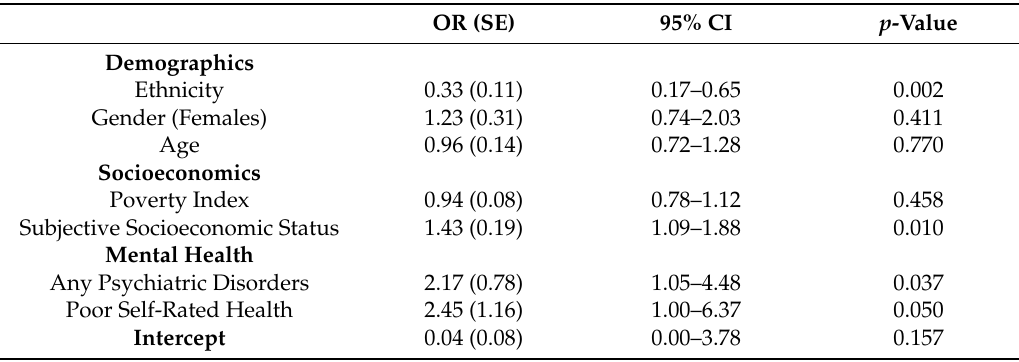
Table 2. Logistic regression in the pooled